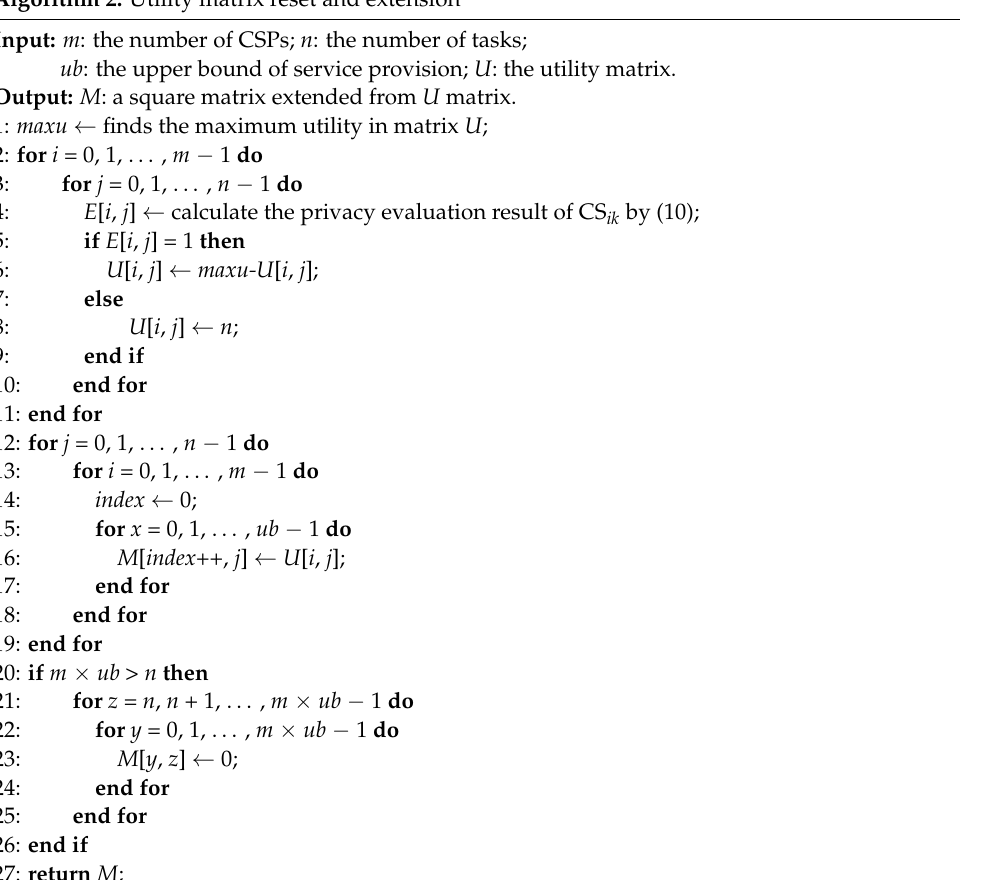
Algorithm 2: Utility matrix reset and